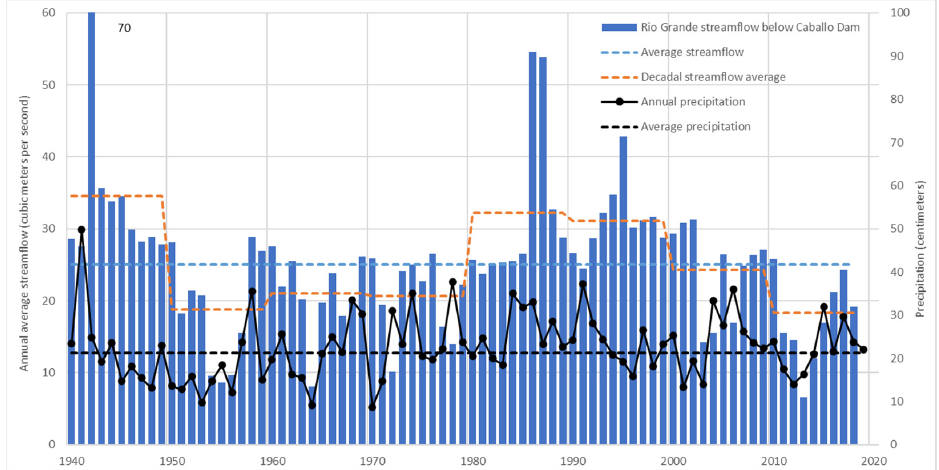
Figure 4. Annual Rio Grande streamflow below Caballo Reservoir from 1940 to 2018 [18,48], average annual streamflow for the period of record, decadal average streamflow, annual precipitation from 1940 to 2019 at the New Mexico State University COOP station [26], and average precipitation for that period of record.